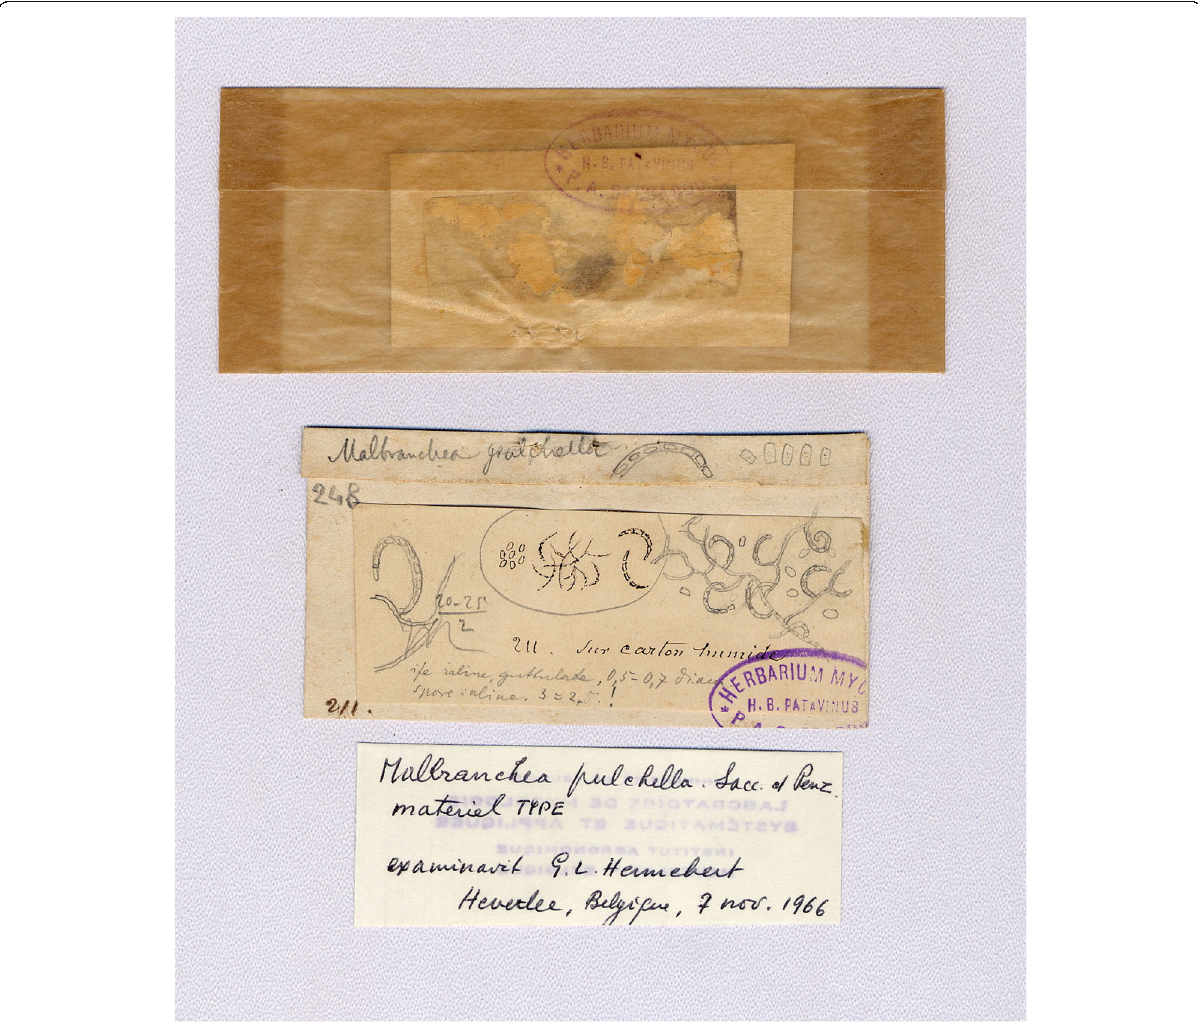
Fig. 1 Malbranchea pulchella Sacc. & Penzig. Holotype and lectotype. Black ink drawings by A. Malbranche, and pencil drawings by P. A. Saccardo (credits: Rosella Marcucci, erbario micologico di Pier Andrea Saccardo, Università di Padova,